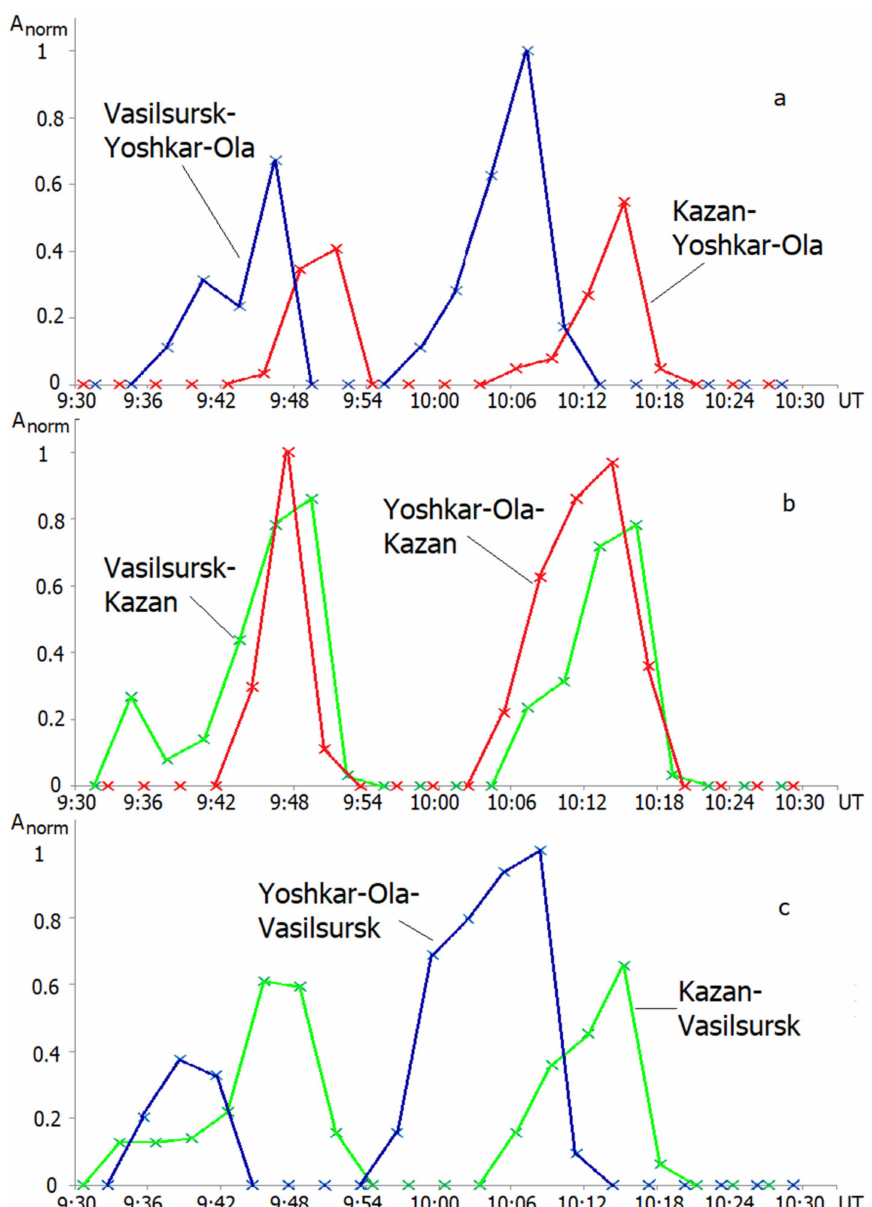
Figure 8. Results of measurements the normalized values of TID signal power on 19 December 2019, during time from 9:30 to 10:30 UT on the paths Vasilsursk-Yoshkar-Ola ( a , c ), Kazan-Yoshkar-Ola ( a , b ), and Kazan-Vasilsursk ( b , c